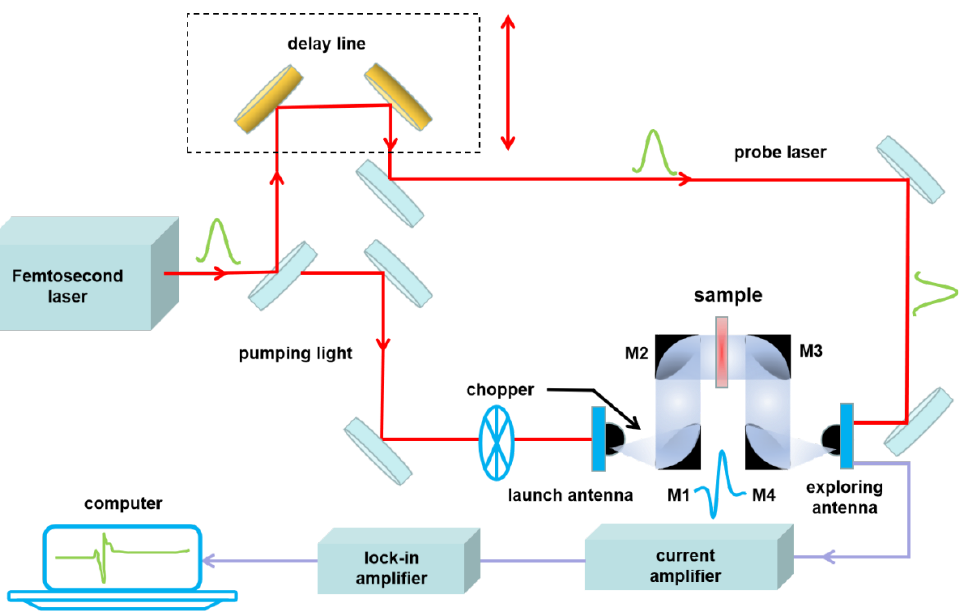
Figure 4. Schematic drawing of THz-TDS system.